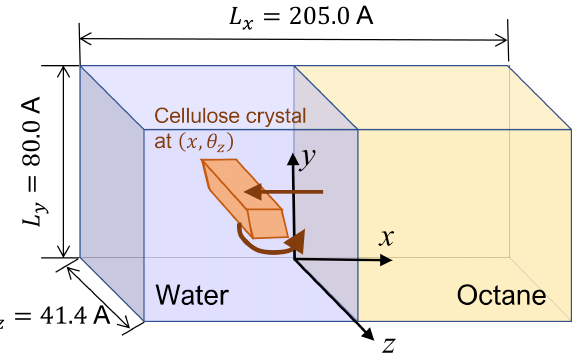
Figure 3. Schematic view of the simulation system.